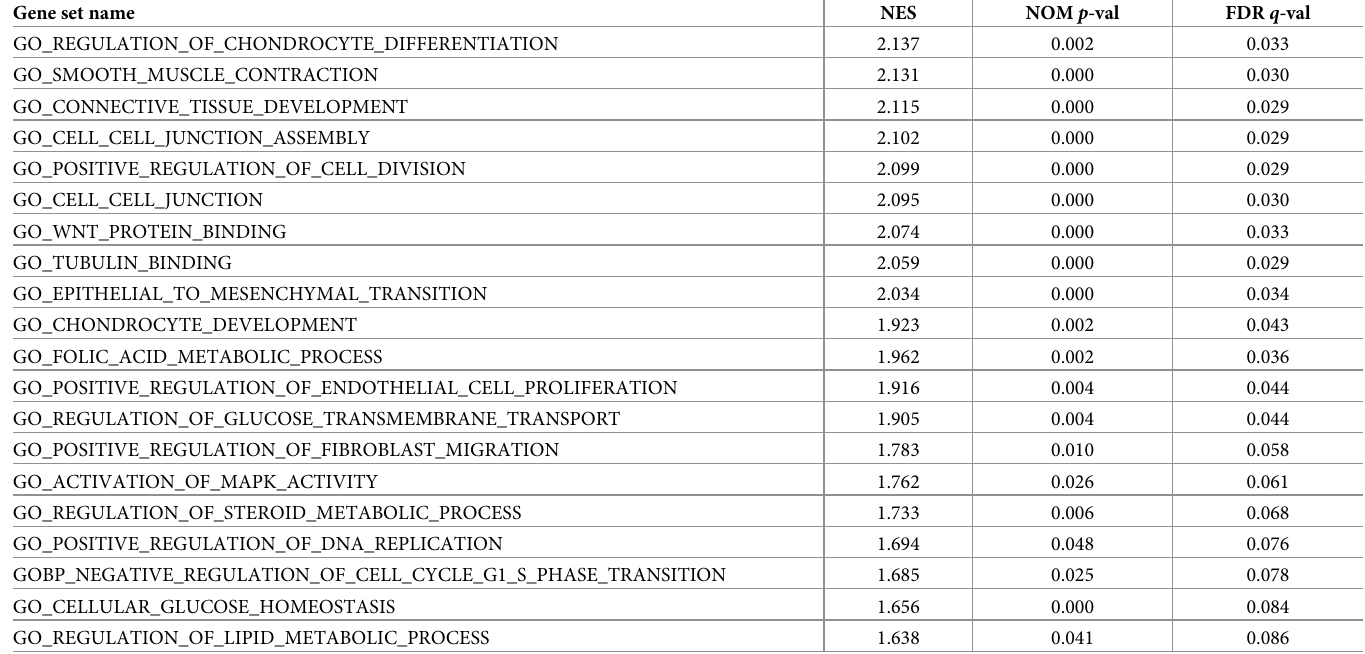
Table 6. Gene sets enriched in the high-risk phenotype via GO. Gene set name